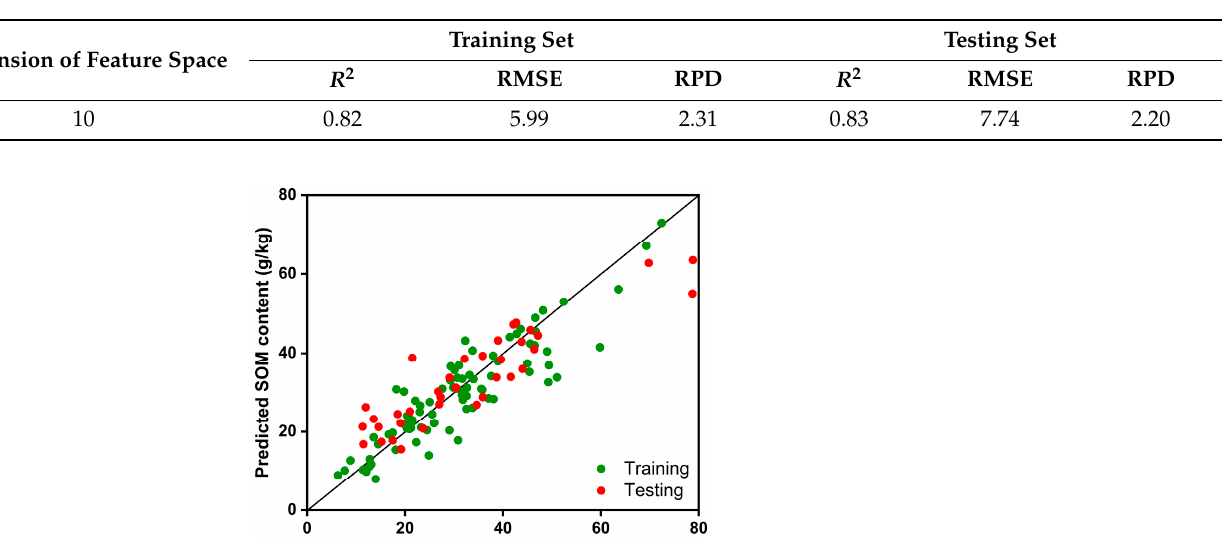
Figure 8. The prediction results of PLSR model established by PCA algorithm.